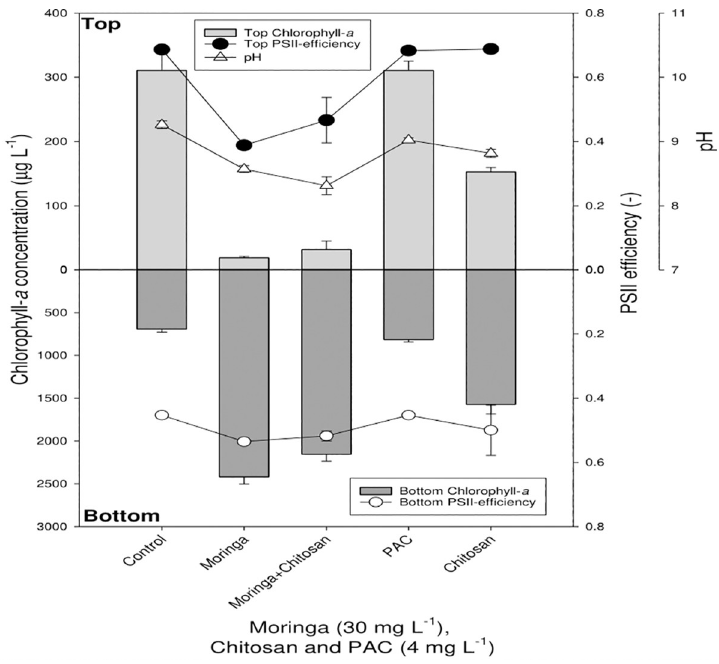
Fig 4. The clearing effect of flocculants on the reservoir water. Chlorophyll- a concentrations ( μ g/ L) in the top 2 mL (top light gray bars) and bottom 2 mL (lower dark gray bars) of 130 μ g/L cyanobacterial suspensions incubated for 1 h with different concentrations of the flocculants: PAC (4 mg Al/ L), chitosan (4 mg/L) and MOS (30 mg/L). Also included are the pH values (open triangles), PSII efficiency in the top (closed circles) and bottom (open circles) of the experimental